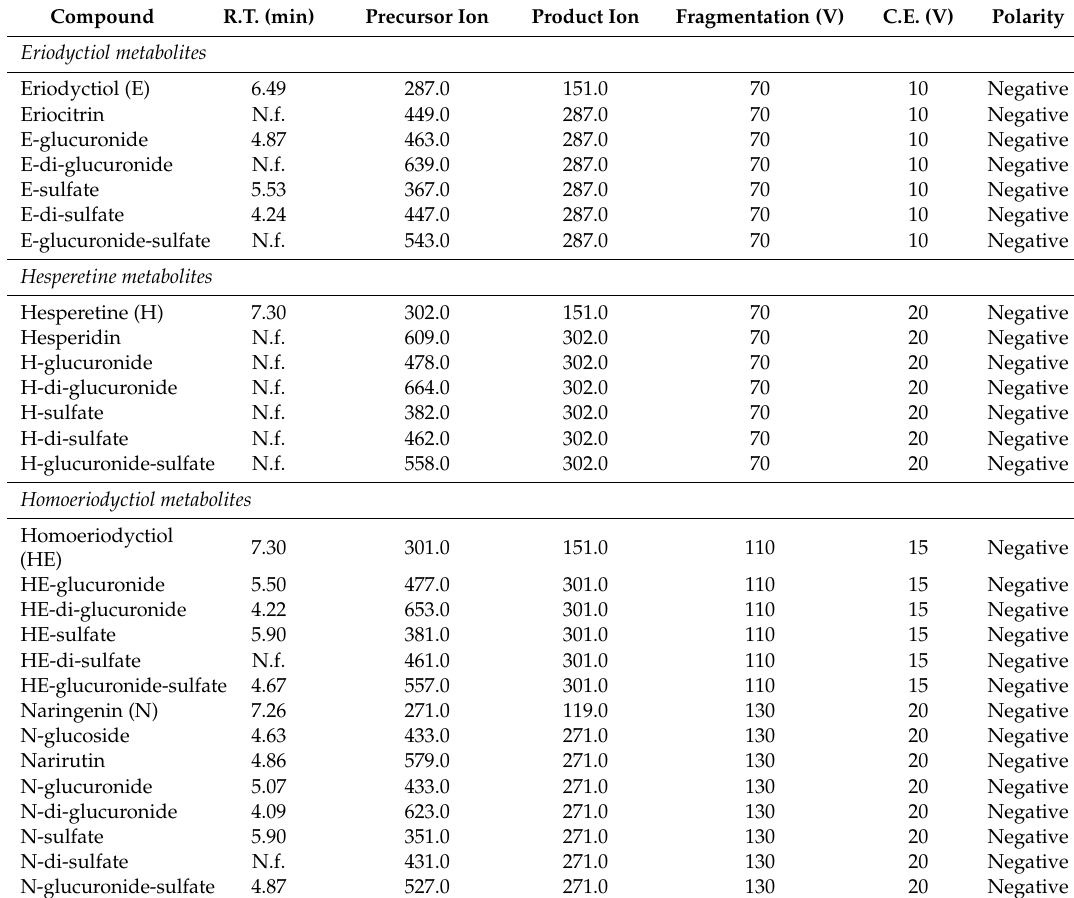
Table 2. Qualitative analysis of flavanone metabolites in urine after the ingestion of maqui-citrus